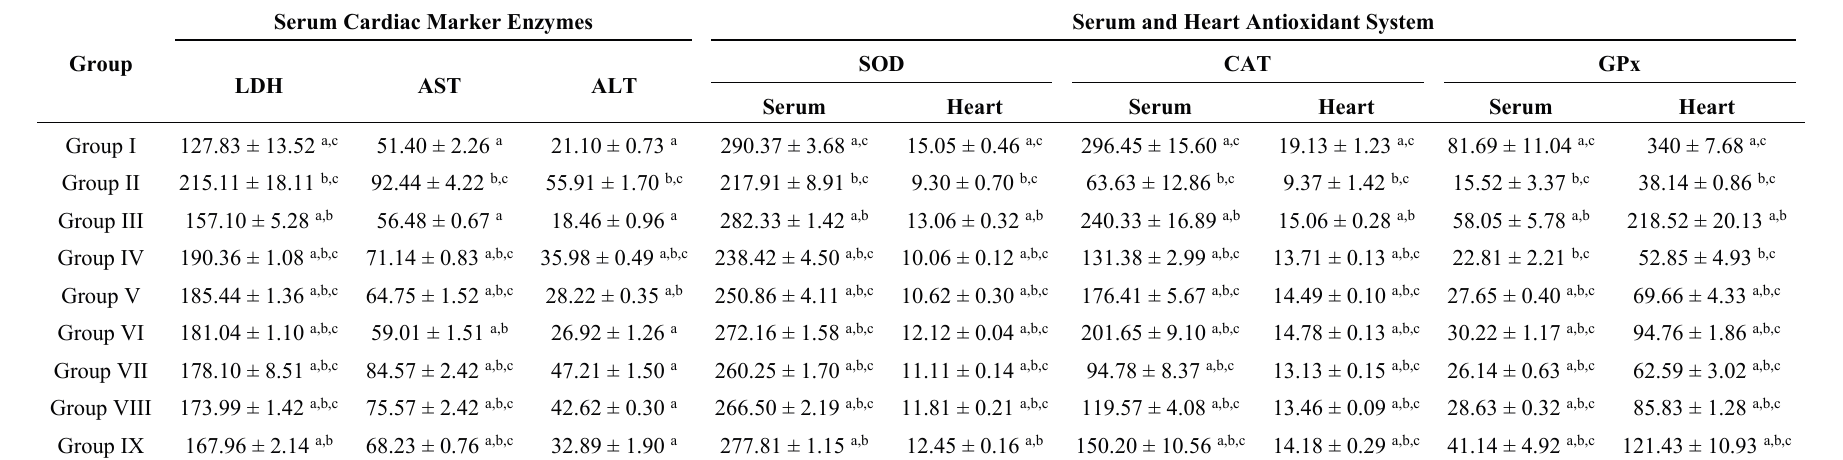
Data is presented as mean ± SD (n = 6). a Significantly different to isoproterenol-induced (negative control) group at p < 0.05; b Significantly different to normal group at p < 0.05; c Significantly different to propranolol (positive control) group at p < 0.05. Activity is expressed as U/L for serum LDH and AST; IU/L for serum ALT; U/mL for serum SOD, CAT and GPx; U/mg protein for myocardium SOD, CAT and GPx. LDH = Lactate dehydrogenase; AST = Aspartate transaminase; ALT =